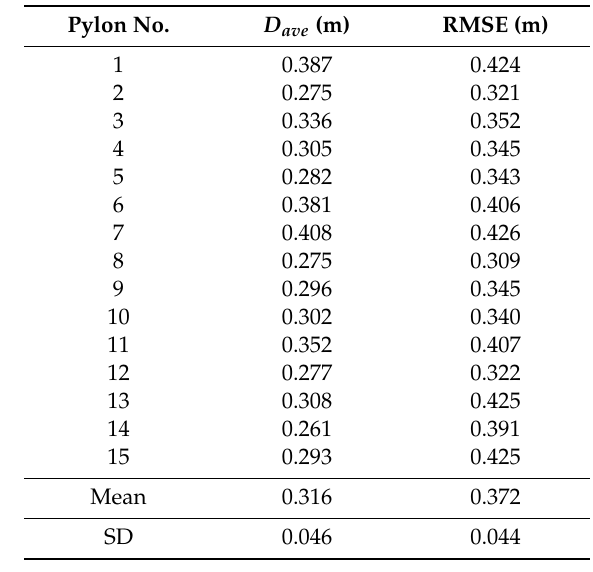
Table 5. The accuracy of pylon head